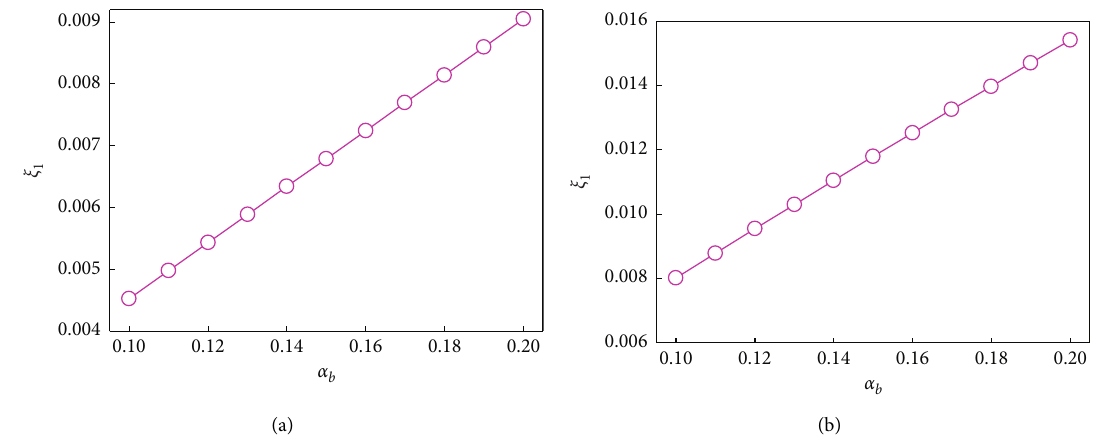
Figure 14: Variations of the first additional modal damping ratio ξ analysis method.